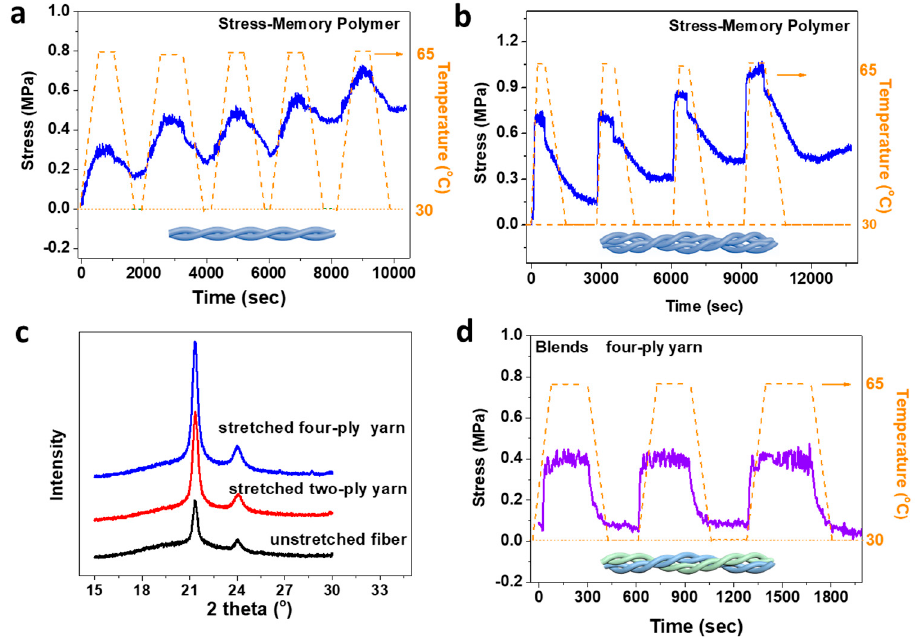
Figure 4. Isometric contraction of ( a , b ) two-ply and four-ply stress–memory polymeric yarns. ( c ) XRD characterization of stress–memory polymer fiber and yarns. ( d ) Isometric contraction of four-ply wool yarn/polymeric yarn blends.